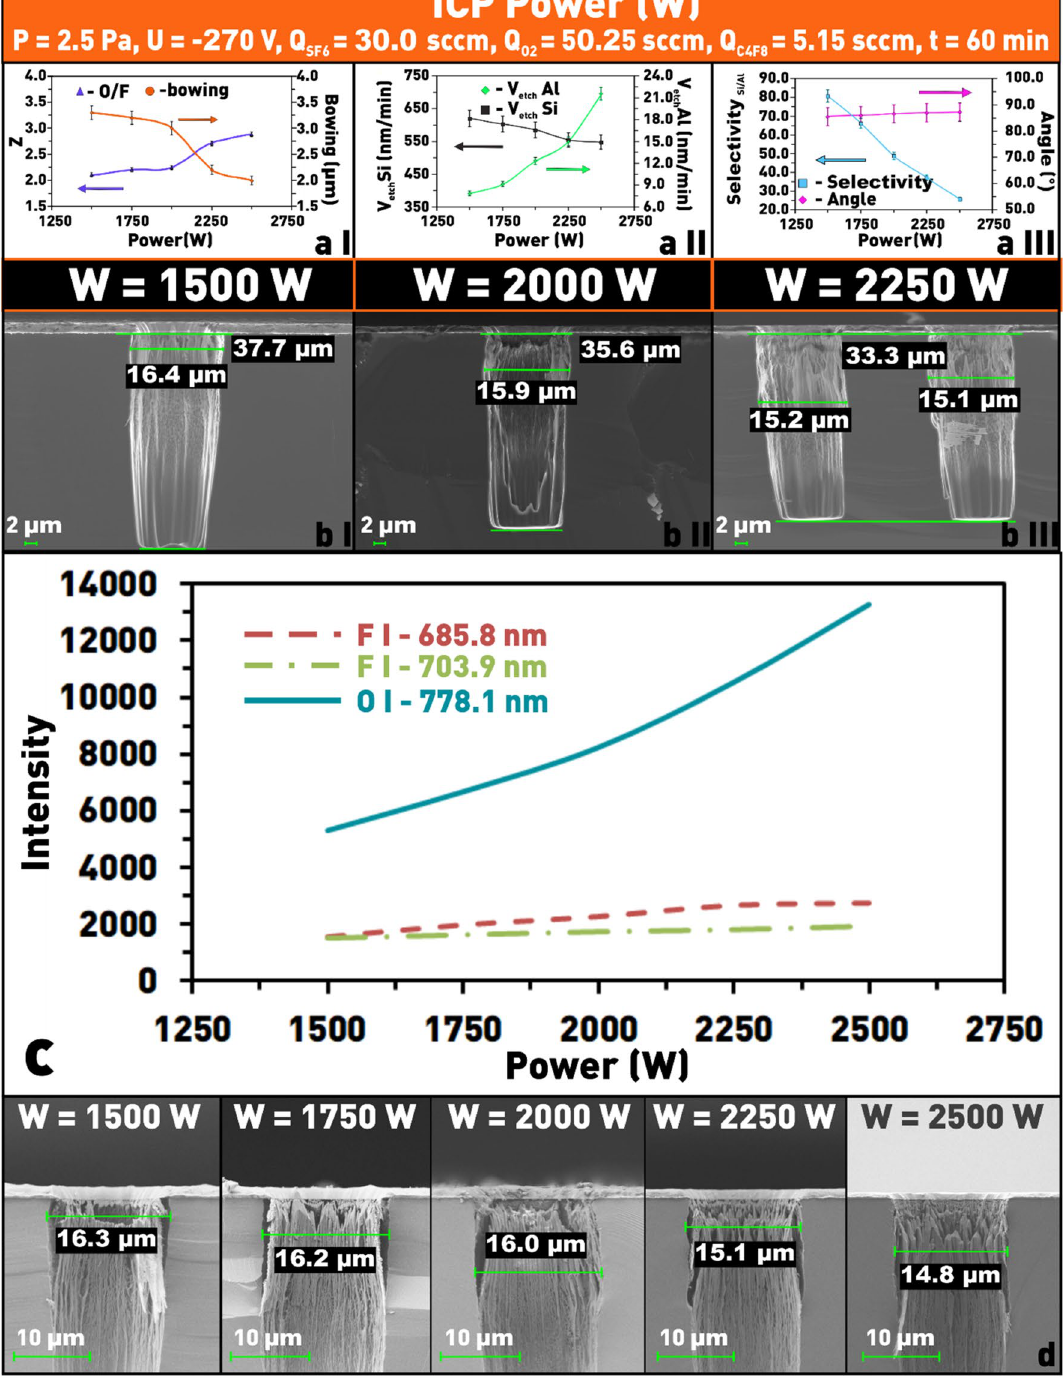
Figure 10. Dependences on the HF power of ICP in SF 6 /C 4 F 8 /O 2 : ( a I ) of δ and Z plasma; ( a II ) of the etching rate of silicon and aluminum; ( a III ) of the etch selectivity and the angle Θ; ( b I – III ) microphotographs of the etching window profiles at different HF power; ( c ) dependences of the emission intensity of fluorine lines (685.8 and 703.9 nm) and oxygen (778.1 nm) depending on the ICP HF power in SF 6 /C 4 F 8 /O 2 plasma; ( d ) microphotographs of etched windows at different values of the ICP HF power in SF 6 /C 4 F 8 /O 2 plasma to evaluate the structure overetching